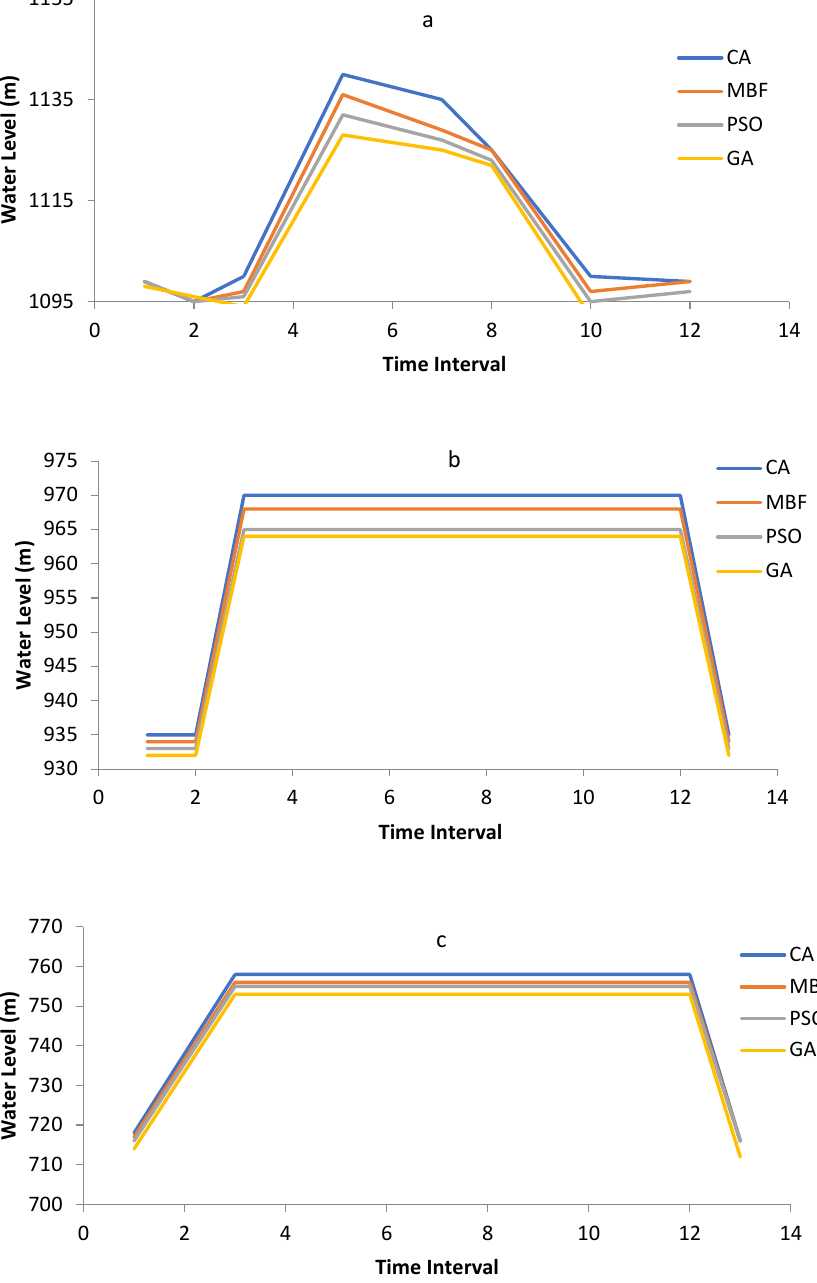
Figure 3. Water level for ( a ) HJD reservoir, ( b ) DF reservoir, and ( c ) WJD.